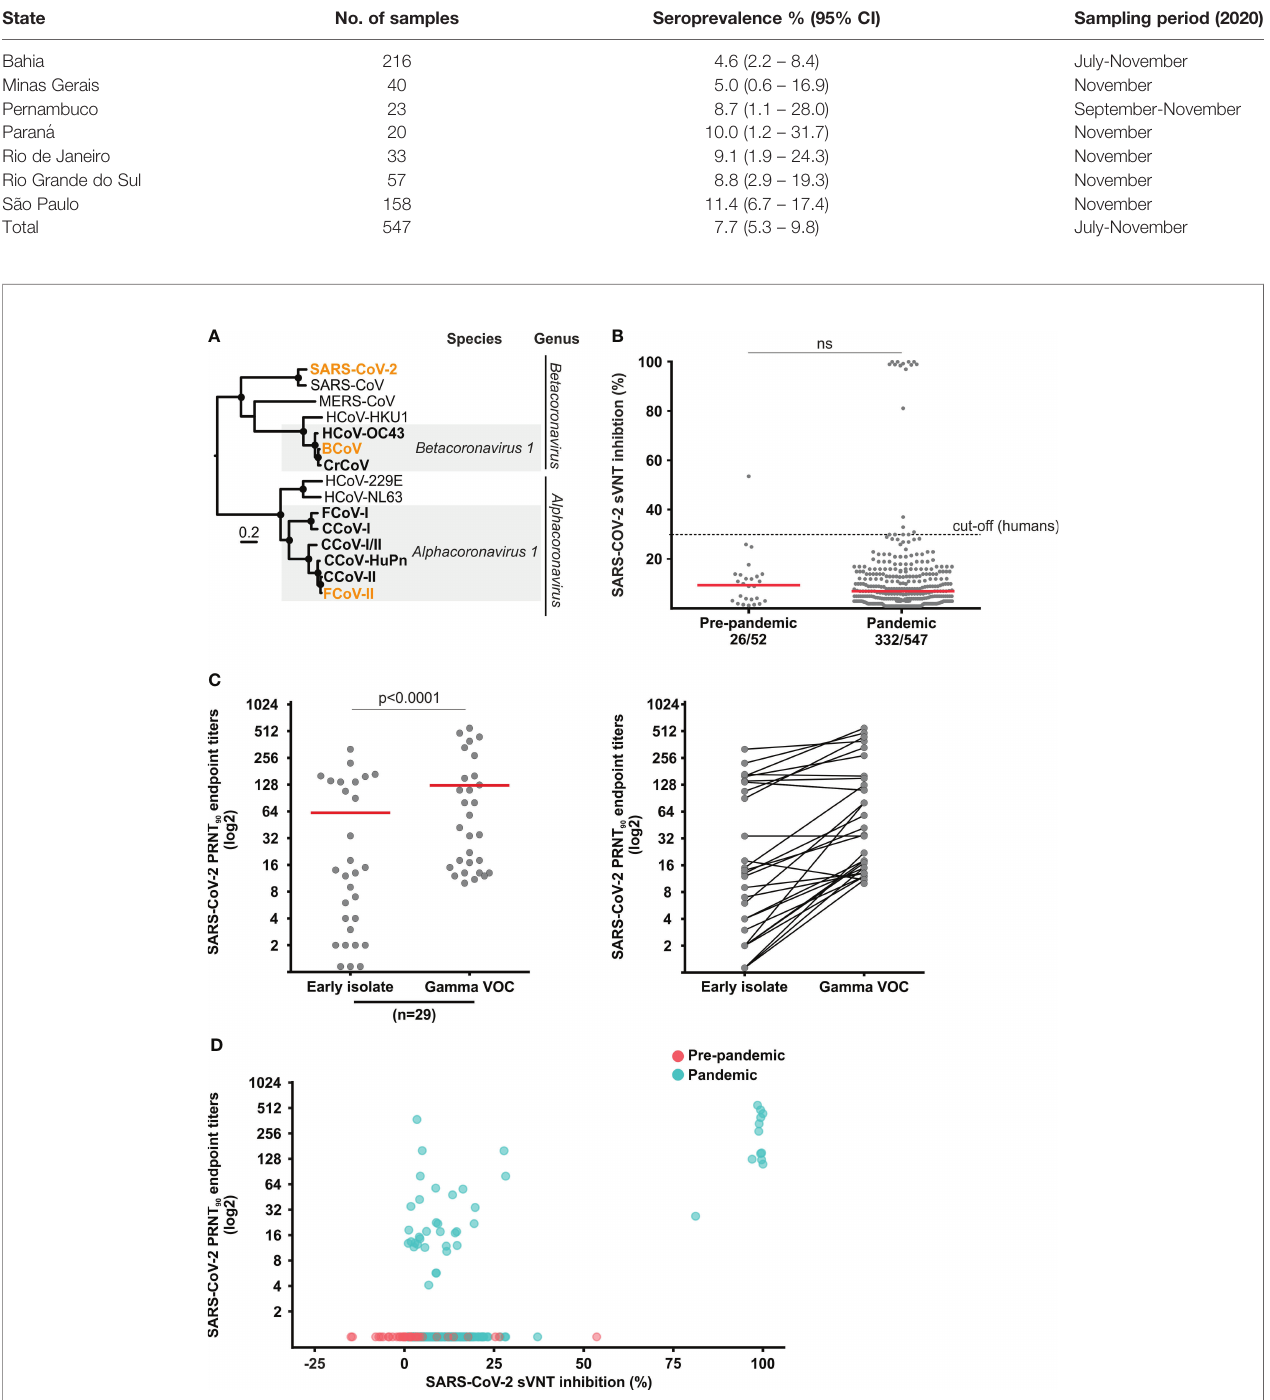
FIGURE 1 | Coronavirus phylogeny and set-up of SARS-CoV-2 serology. (A) Maximum-likelihood tree based on translated spike gene sequences of human, dog and cat coronaviruses. The strains used for testing in this study are highlighted in orange. WAG+G+I was used as a substitution model and a complete deletion option was chosen. Scale bar indicates amino acid substitutions per site. Circles at nodes indicate support of grouping in ≥ 75% from 1,000 bootstrap replicates. (B) sVNT inhibition rate in sera from cats sampled before and during the pandemic. The 30% inhibition cut-off above which a human serum sample is considered positive is given for comparison. (C) Comparison of SARS-CoV-2 PRNT 90 endpoint titers between an early isolate and a Gamma VOC strain. Statistical signi fi cance was determined using the Wilcoxon matched-pairs signed rank test. (D) Comparison of sVNT inhibition rates and reciprocal PRNT endpoint titers. Red bars in panels (B, C) indicate medians; ns, not statistically signi fi cant.